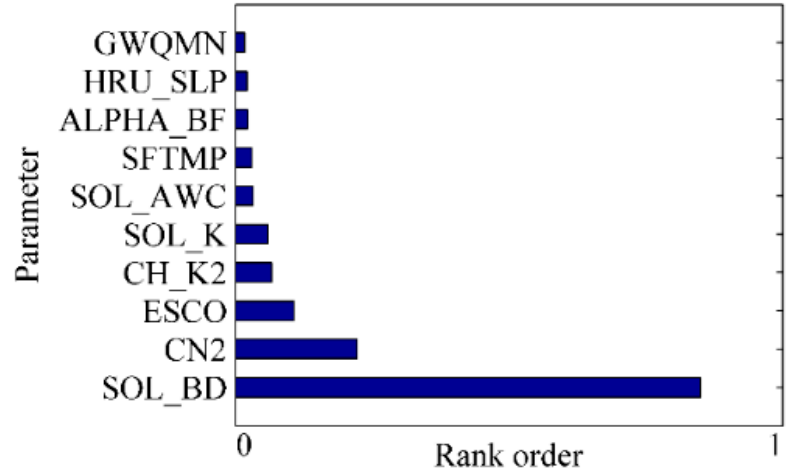
Figure 2. Graphical representation of the sensitivity ranking of the parameters (longer bars indicate greater parameter sensitivities).